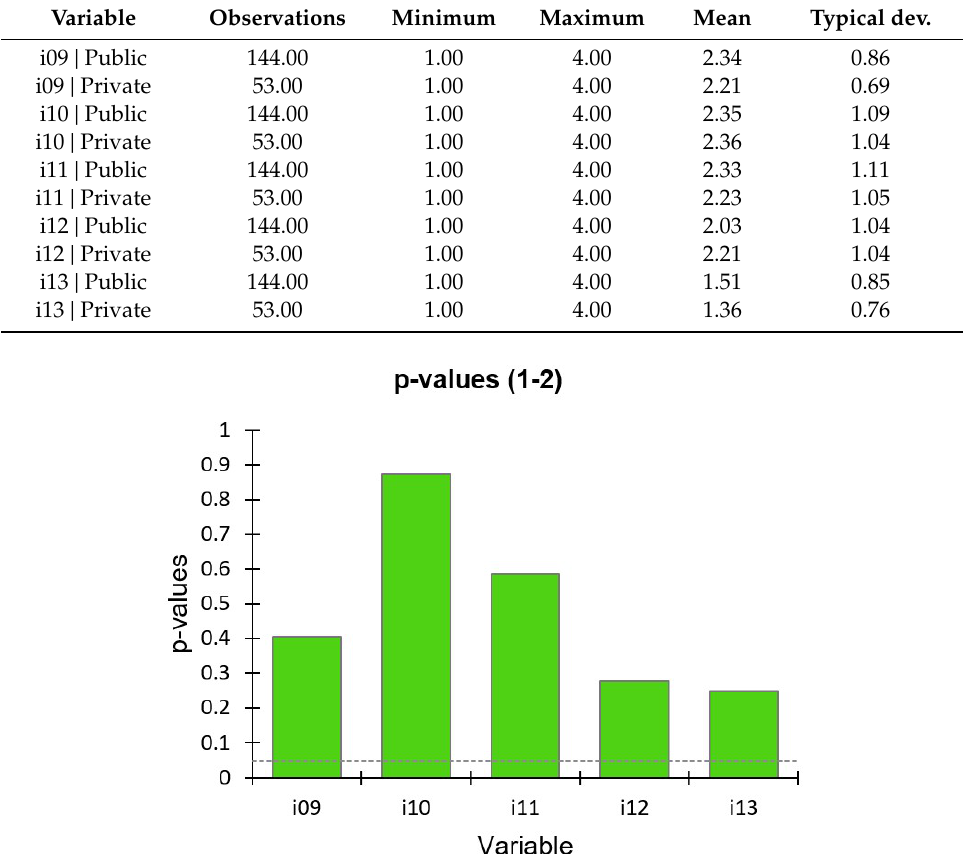
Figure 5. P -values of the Mann–Whitney U test of items concerning the educational design of the program according to whether it is public or private.